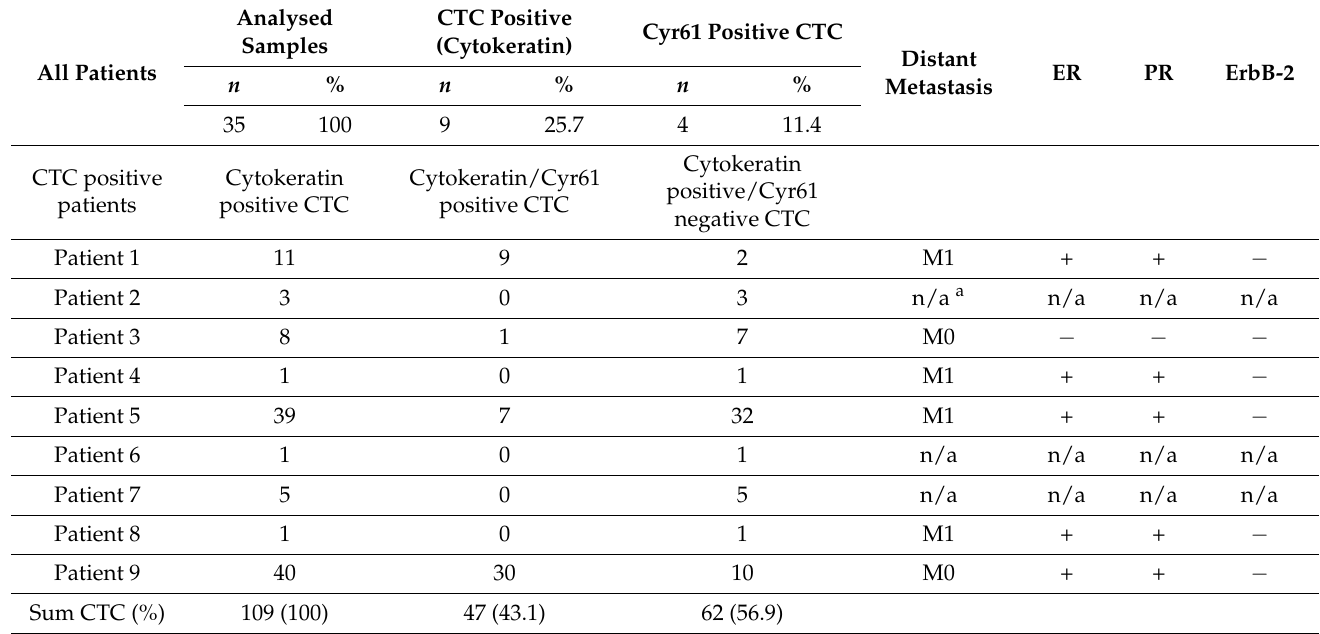
Table 1. CTC and Cyr61 detection rates in the blood samples from breast cancer patients. ER: estrogen receptor alpha status; PR: progesterone receptor